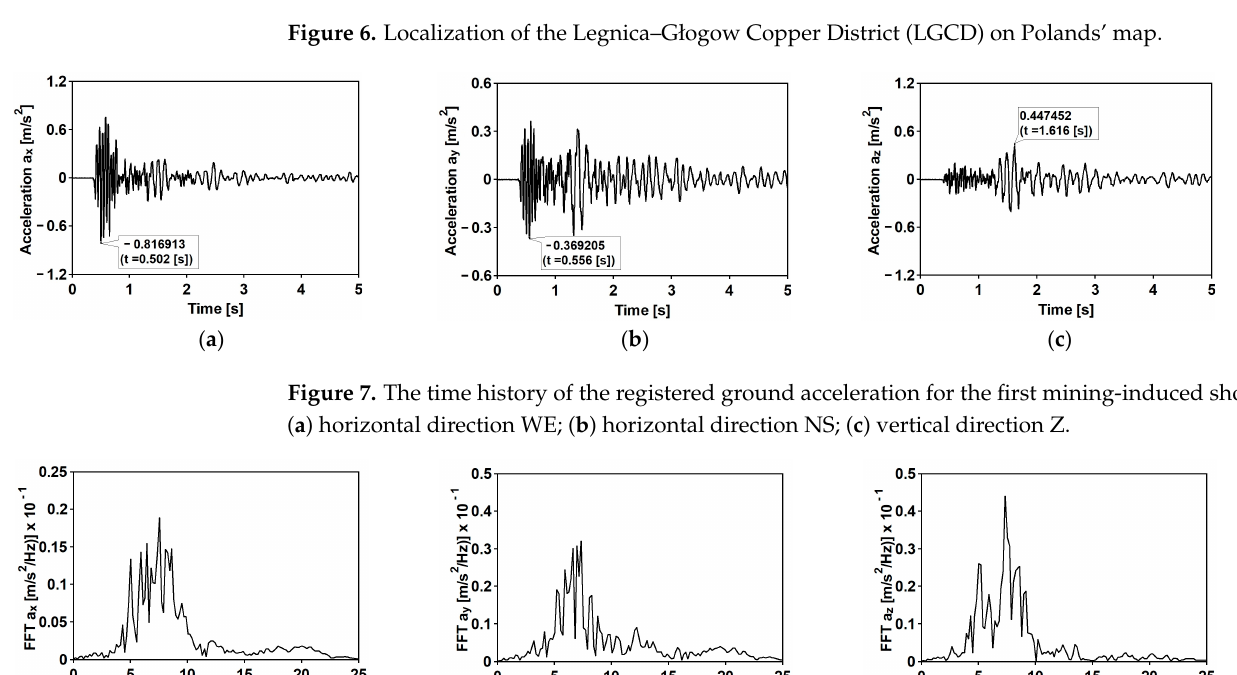
Figure 7. The time history of the registered ground acceleration for the first mining-induced shock: ( a ) horizontal direction WE; ( b ) horizontal direction NS; ( c ) vertical direction Z.